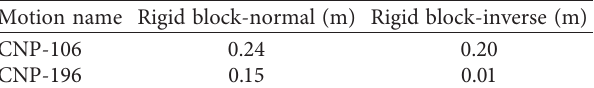
Figure 10: Postliquefaction yield acceleration calculation of the Wynne Street. Table 6: Newmark displacement analysis results by the simplified method (the reported displacement is reported as